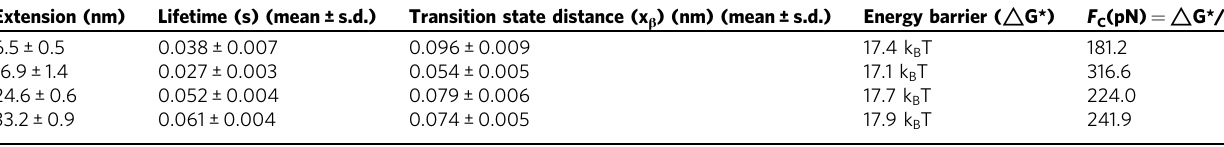
Table 1 The kinetic parameters of all unfolding steps of Cdh23 EC1-27 in PAP mode. Extension